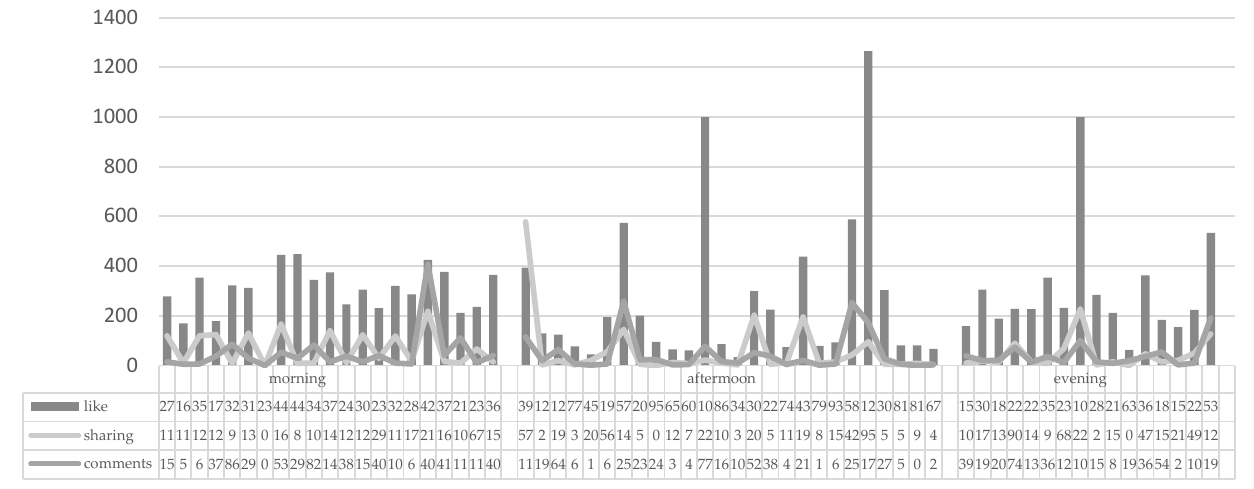
Figure 4. Summary of the intensity of engagement of Facebook users between 1 and 21 July 2020. Source: authors’ own elaboration based on Facebook data.